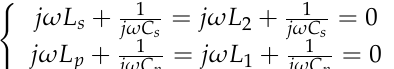
Figure 10. Dual-LCL compensation model and equivalent circuit: ( a ) dual-LCL compensation model, ( b ) dual-LCL equivalent circuit.